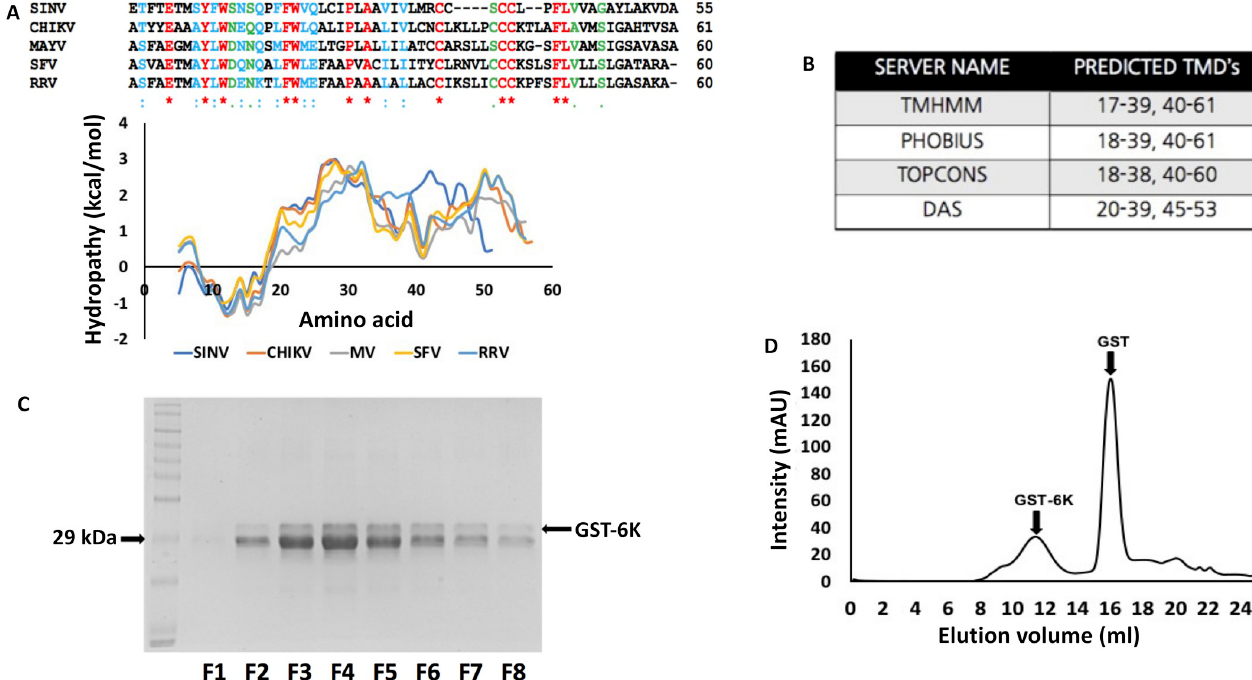
Fig 1. 6K sequence analysis and GST-6K purification: (A) A comparative analysis of the hydrophobicity of 6K peptides encoded by different members of the alphavirus family. Kyte-Doolittle hydrophobicity plots and multiple sequence alignment of 6K peptides from different alphaviruses—Chikungunya (CHIKV), Semliki Forest Virus (SFV), Sindbis Virus (SINV), Ross River Virus (RRV) and Mayaro Virus (MV) are shown. Sequence alignment color legend: red-identical residues; blue-highly similar residues and green-less similar residues. (B) Potential transmembrane domains in CHIKV 6K as predicted by different servers as indicated. (C) SDS-PAGE of GST-6K after pulldown with GST beads. Lane 1 corresponds to the molecular weight ladder, while lanes 2 to 9 correspond to protein fractions. (D) Gel filtration profile of GST-6K on Superdex 200 10/300 G/L